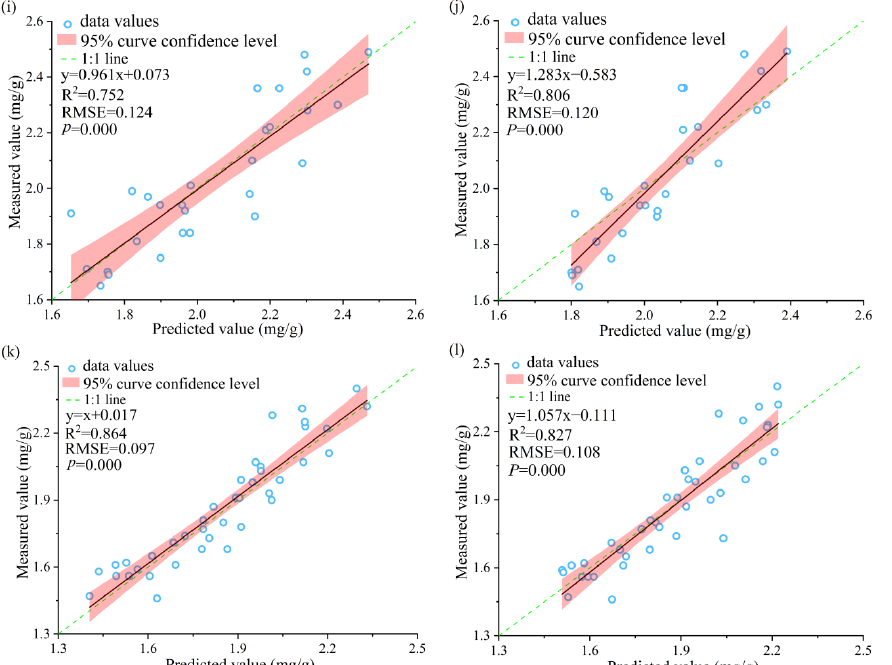
Figure 8. Estimated nitrogen content of Moso bamboo from two regression models for Moso bamboo leaves in different damage states: ( a ) Whole samples PLS model; ( b ) whole samples SVR model; ( c ) H-PLS; ( d ) H-SVR; ( e ) Mi-PLS; ( f ) Mi-SVR; ( g ) Mo-PLS; ( h ) Mo-SVR; ( i ) S-PLS; ( j ) S-SVR; ( k ) O-PLS; ( l ) O-SVR. partial least squares (PLS); support vector regression (SVR).